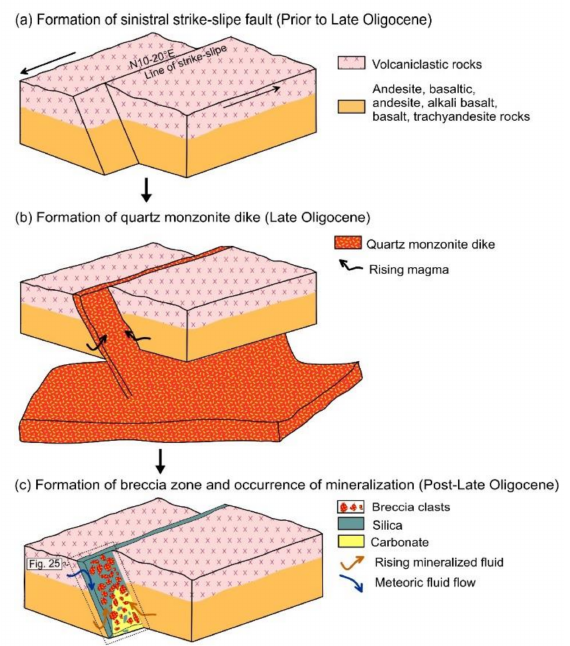
Figure 24. Block diagrams showing structural and mineralization evolution of the Shah-Ali-Beiglou deposit in the study area. ( a ) Displacement of rock units by sinistral strike-slip fault in a N10 ◦ –20 ◦ E direction; ( b ) Rising quartz monzonite magma through the fault and formation of dike along the fault plane; ( c ) Development of ore mineralization along breccia zone within the quartz-monzonite dike as vein-veinlet, breccia cement and disseminated.